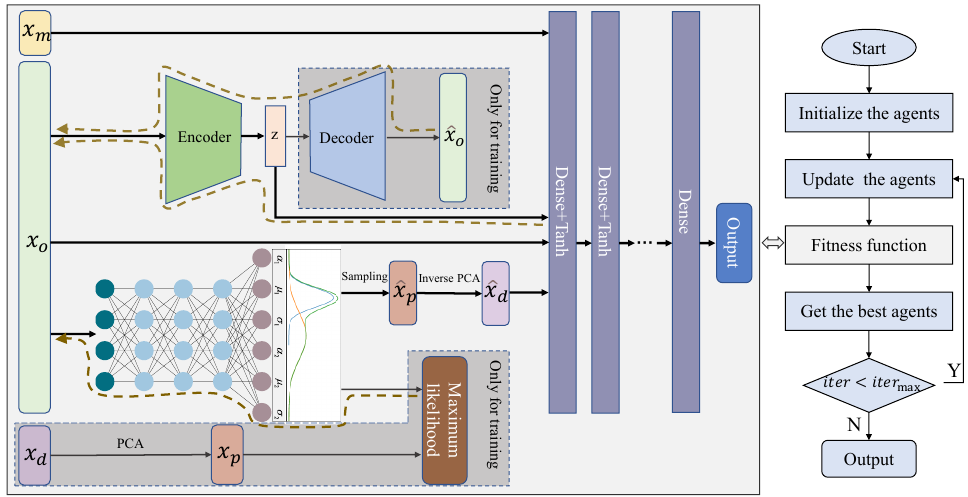
Figure 9. The proposed consistency optimization